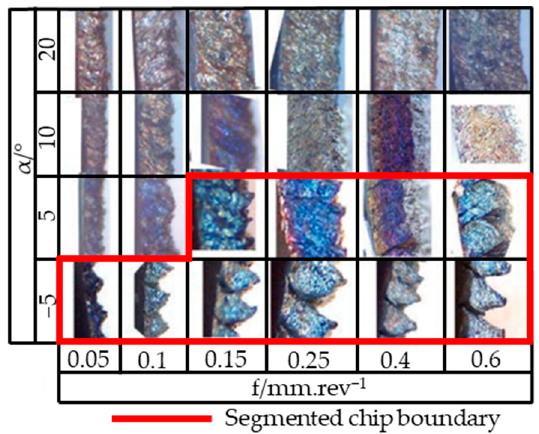
Figure 7. Chip morphology obtained through experimental investigation under varying rake angle and feed at a constant cutting speed of 150 m/min. with the boundary differentiating between continuous and segmented chip. Note: Image magnification not to scale.